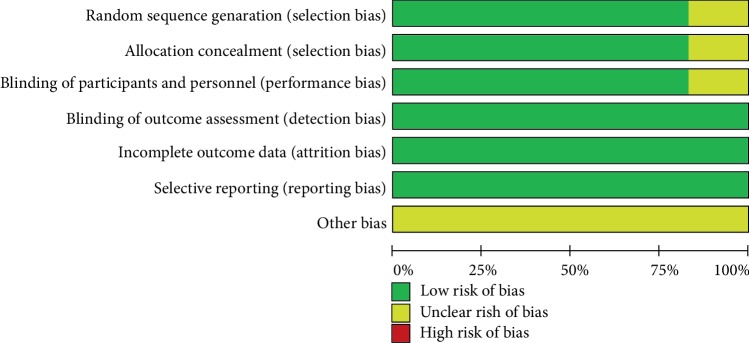
Risk of bias graph.